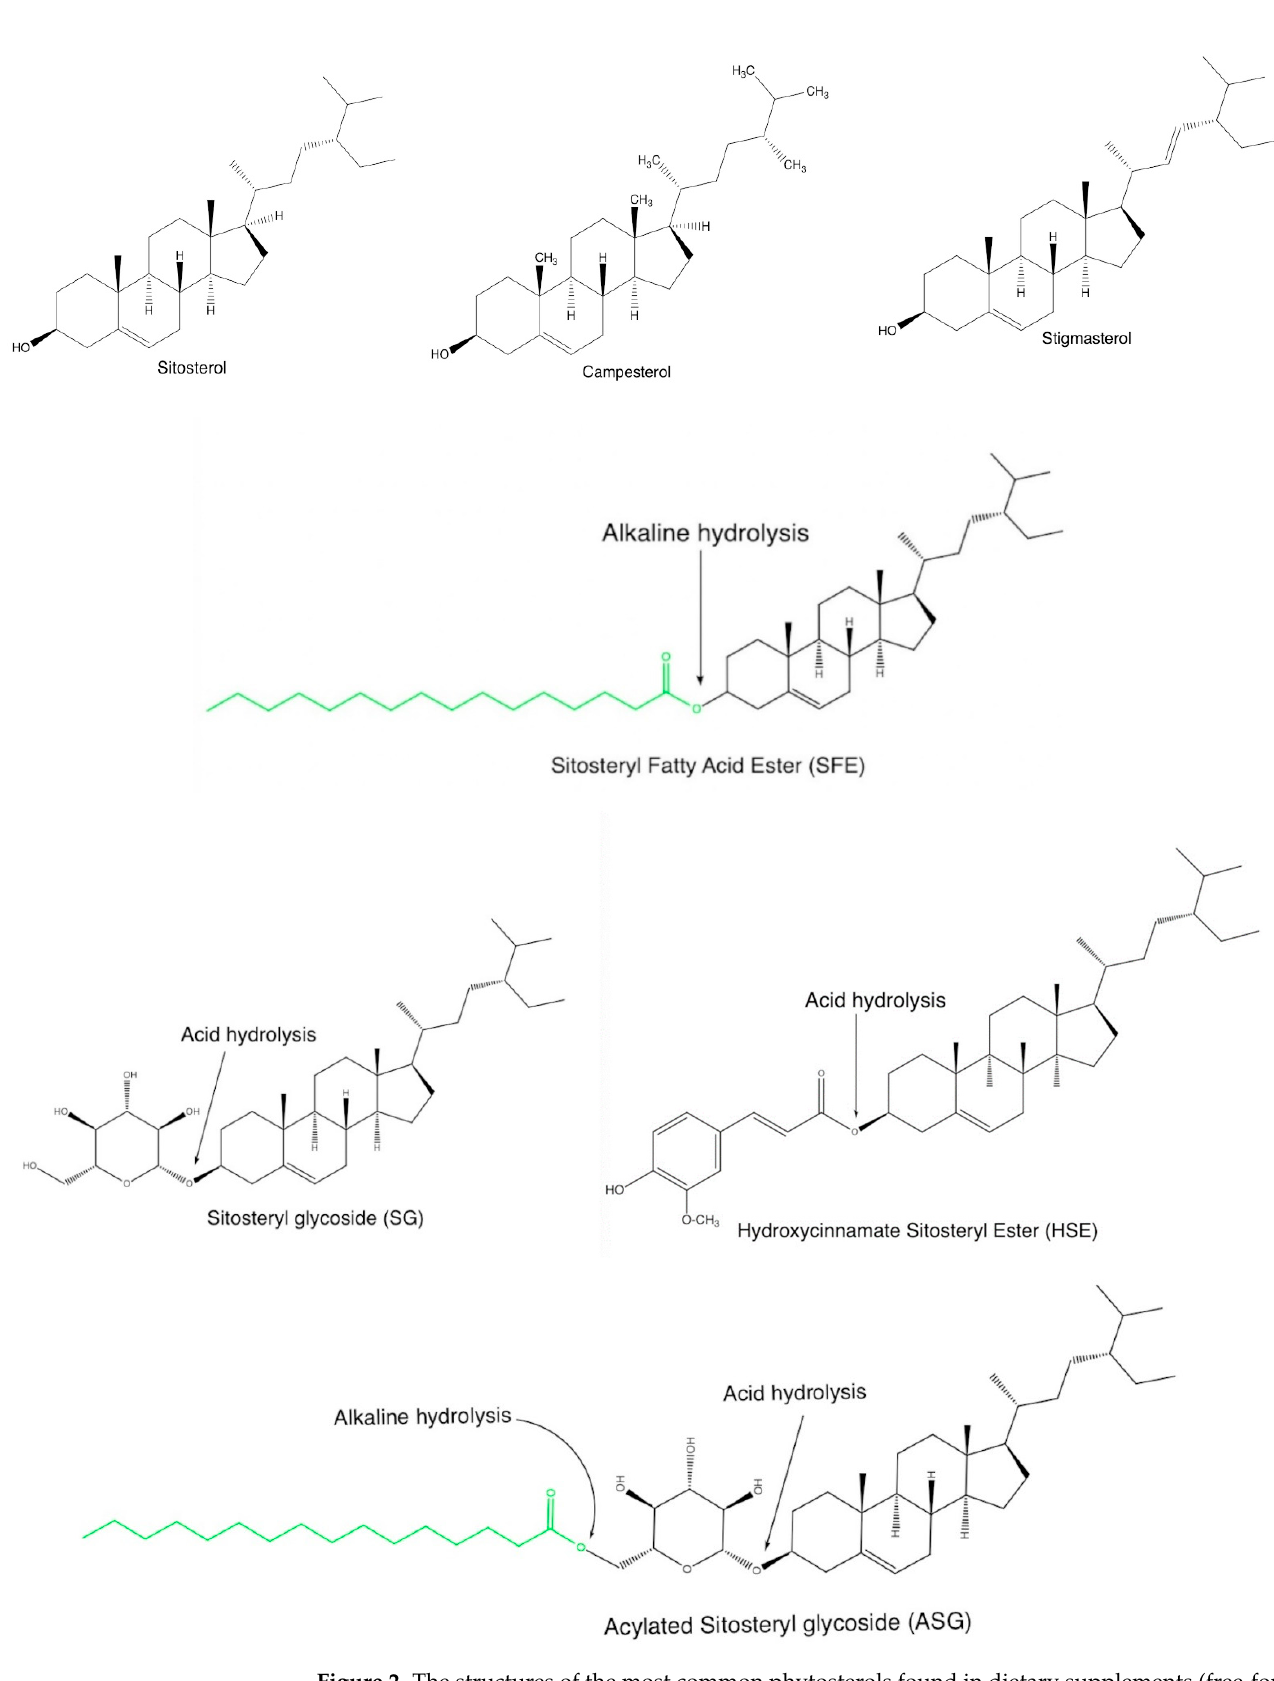
Figure 2. The structures of the most common phytosterols found in dietary supplements (free-form FPS and conjugated CPS); green radical—fatty acid residue;